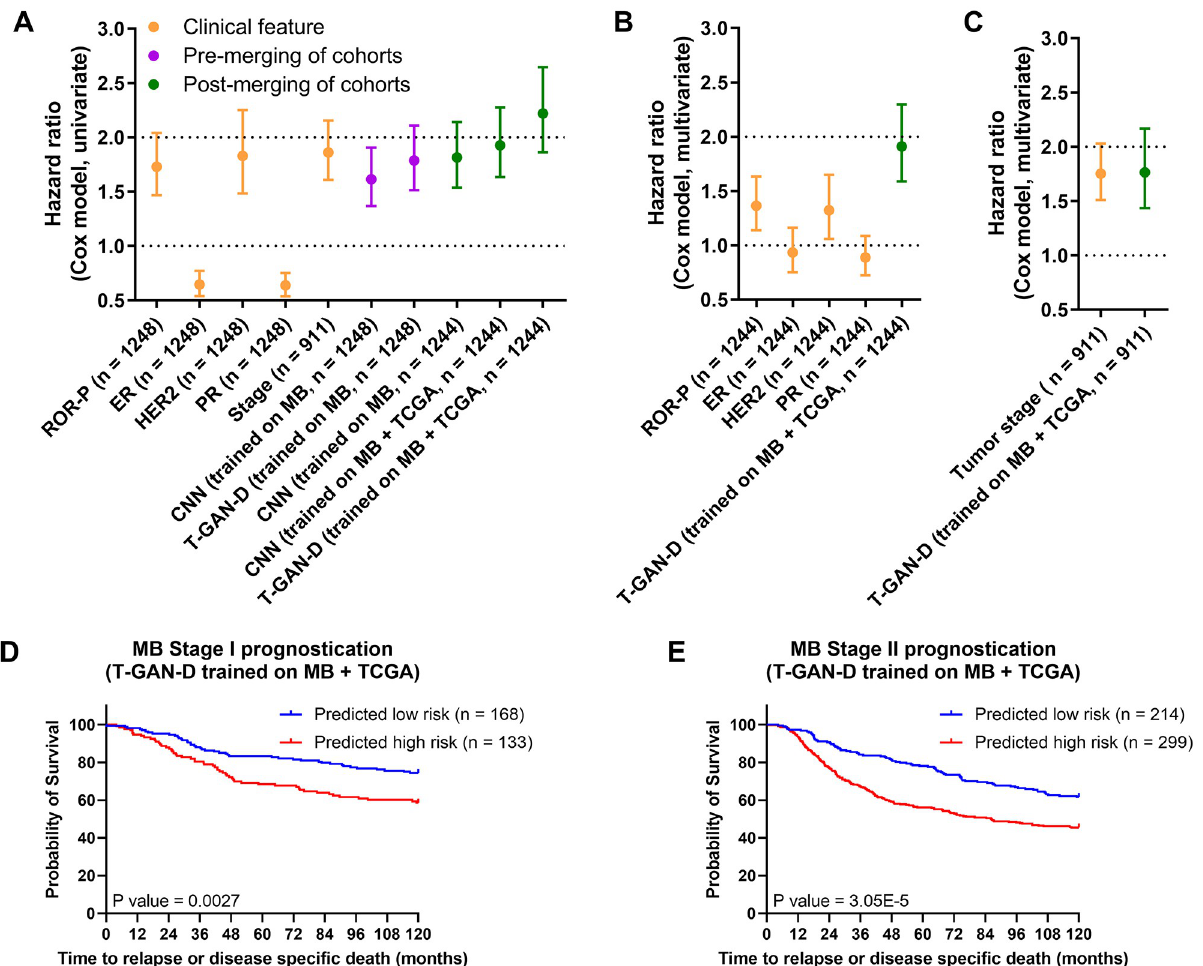
Fig 4. The T-GAN-D outperforms classical biomarkers after merging the MB and TCGA cohorts and significantly stratifies early stage MB patients. ( A ) Comparison of the hazard ratios (Cox model, univariate) of a multi-transcript signature (ROR-P) and established prognostic biomarkers (ER, HER2, PR) vs. the CNN and the T-GAN-D before and after cohort merging. ( B ) Multivariate Cox hazard ratio of the T-GAN-D compared to ROR-P and receptor status and ( C ) disease stage. ( D ) Kaplan -Meier curves of Stage I and ( E ) Stage II patients stratified by the T-GAN-D into low and high risk